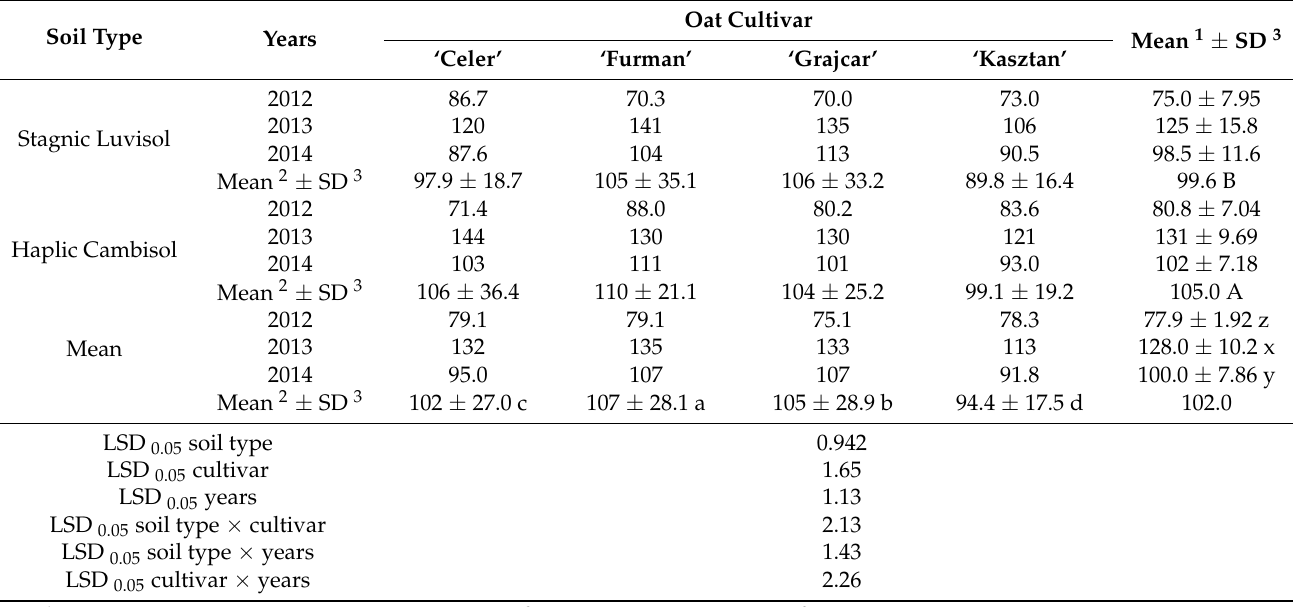
Table 15. Total protein content in oat grain (g kg − 1 ) grown in the mixtures, depending on the soil type (factor I), oat cultivar (factor II), and study years (factor